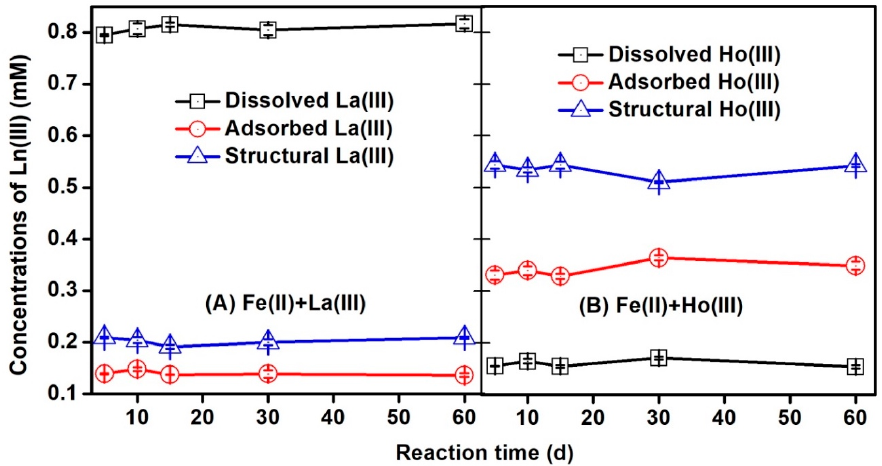
Figure 5. The concentrations of La(III) ( A ) and Ho(III) ( B ) species during the Fe(II) aq -induced phase transformation of ferrihydrite in the presence of La(III) and Ho(III), respectively.